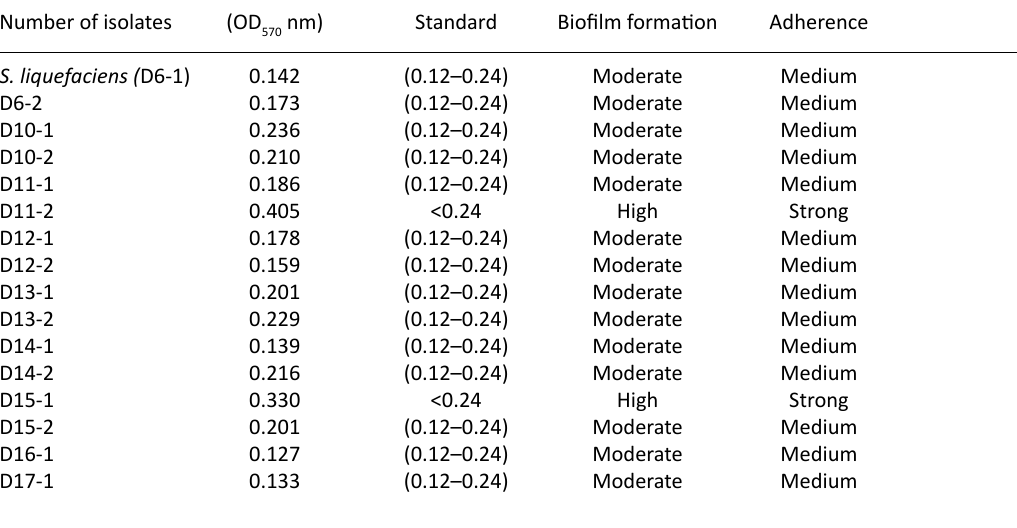
Table 8. Biofilm formation by Tissue Culture Plate (TCP) of Domiaty cheese isolates nm) Number of isolates (OD 570